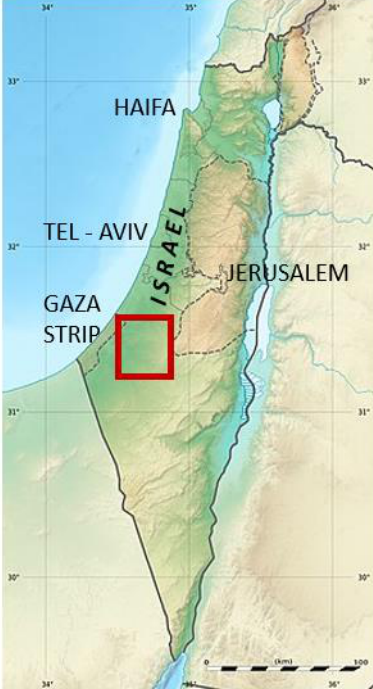
Figure 1: Study Site in the South Eastern